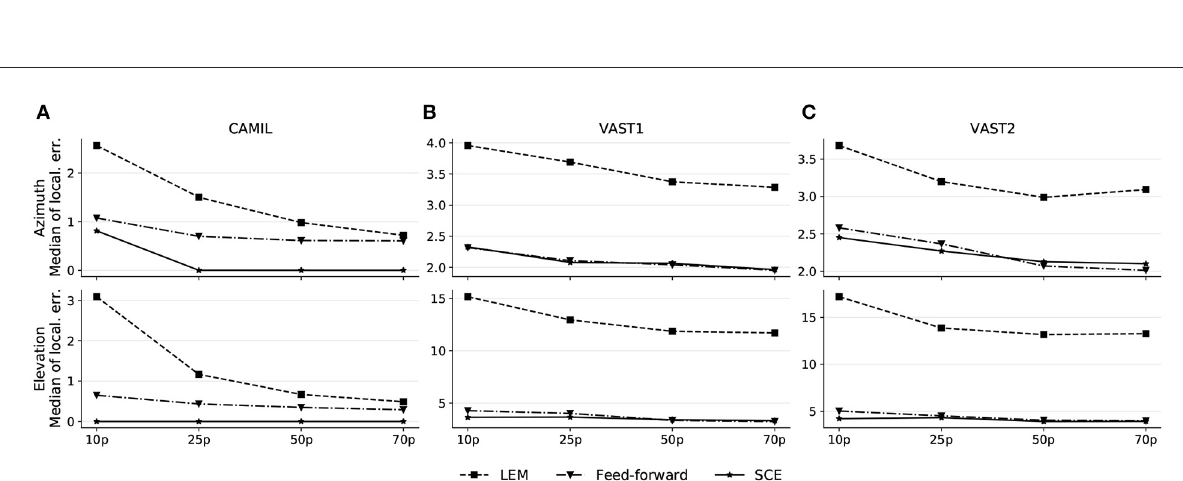
however, the median localization error of the proposed SCE does not vary much with the changing size of the training set, and shows a flatter pattern. Although in the fixed acoustic condition, SCE results a in a higher median error when 10% of the training set is used (median azimuth error equal to 0.81 ◦ ) than when a larger training set is used, the error is still lower than for the other two methods (as feed-forward and LEM achieve median azimuth errors equal to 1.08 ◦ and 2.56 ◦ respectively when 10% of the training data is used). This allows to conclude that the SCE is more robust to the use of training data that not cover the entire latent